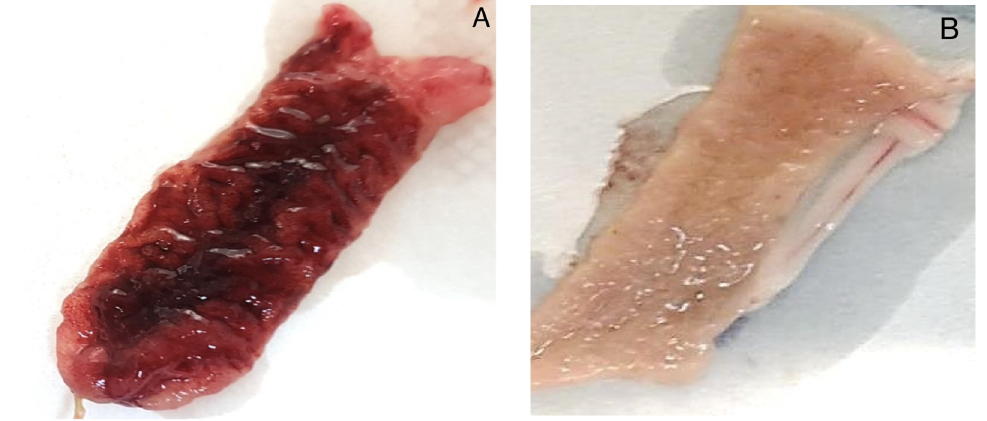
Figure 4. Macroscopic evaluation of rabbit ileal loops, 12 h after the inoculation of the AB170 strain. ( A ) Macroscopic hemorrhagic aspect of the intestine 12 h after the inoculation of A. butzleri . ( B ) Negative control. Intestinal tissue inoculated with PBS.